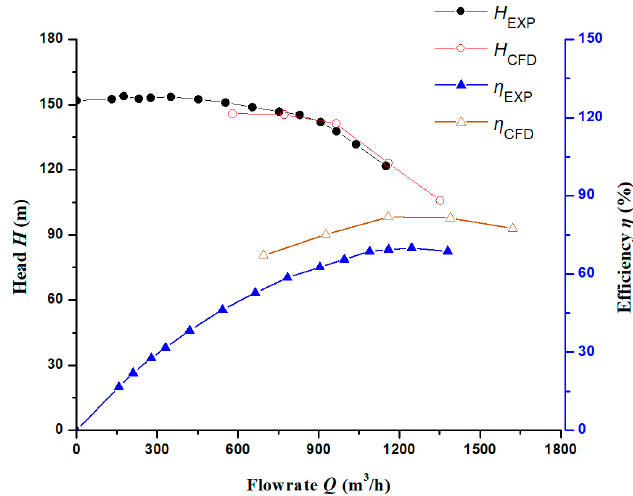
Figure 7. Comparison of experimental and simulated external performance curves.